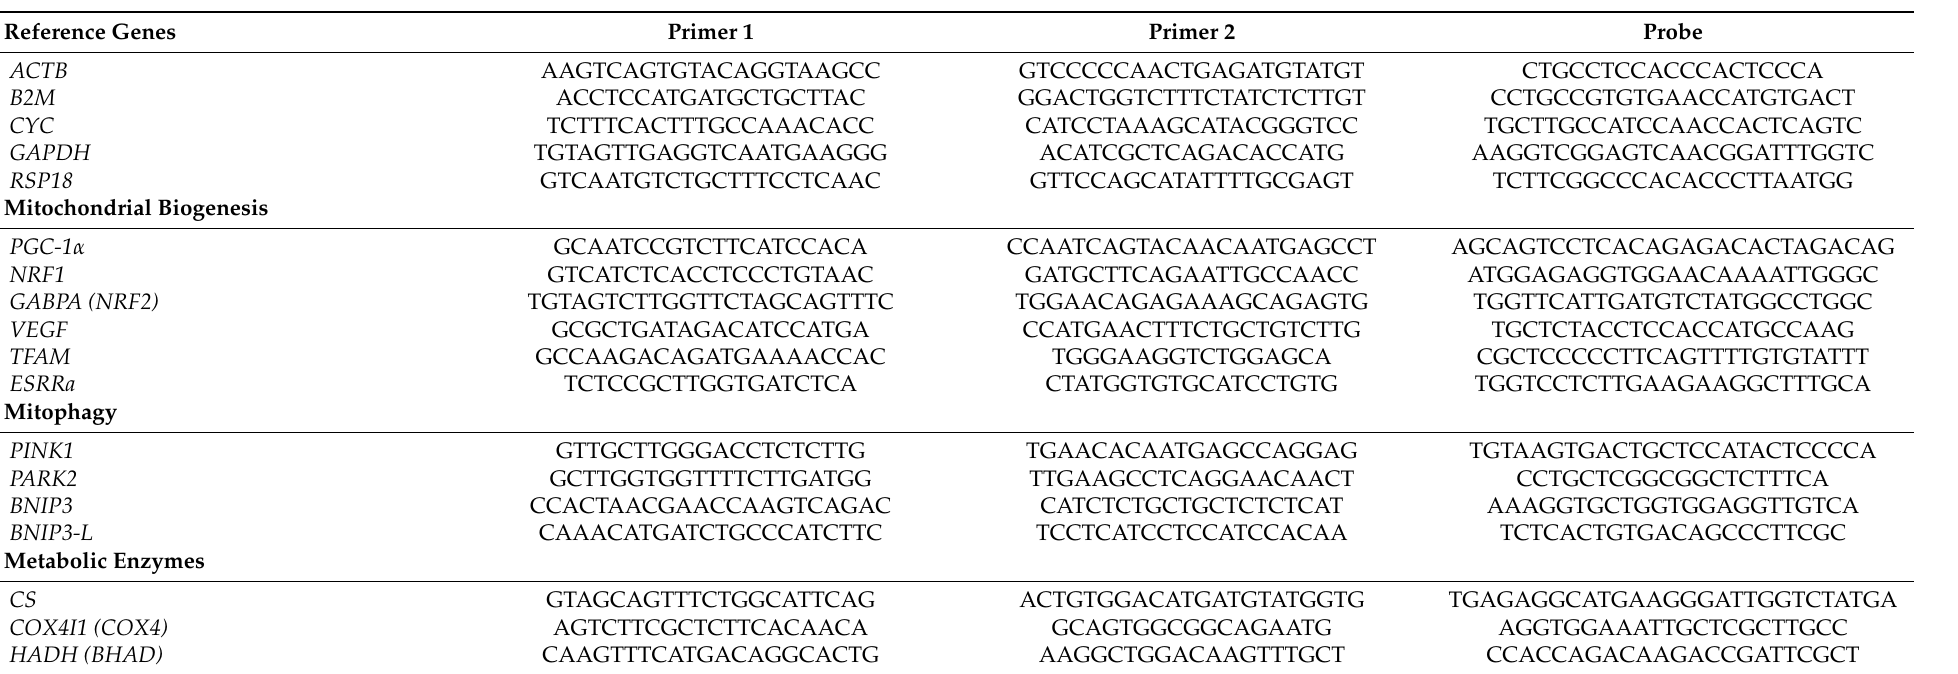
Table 1. Probes and Primers Supplementary